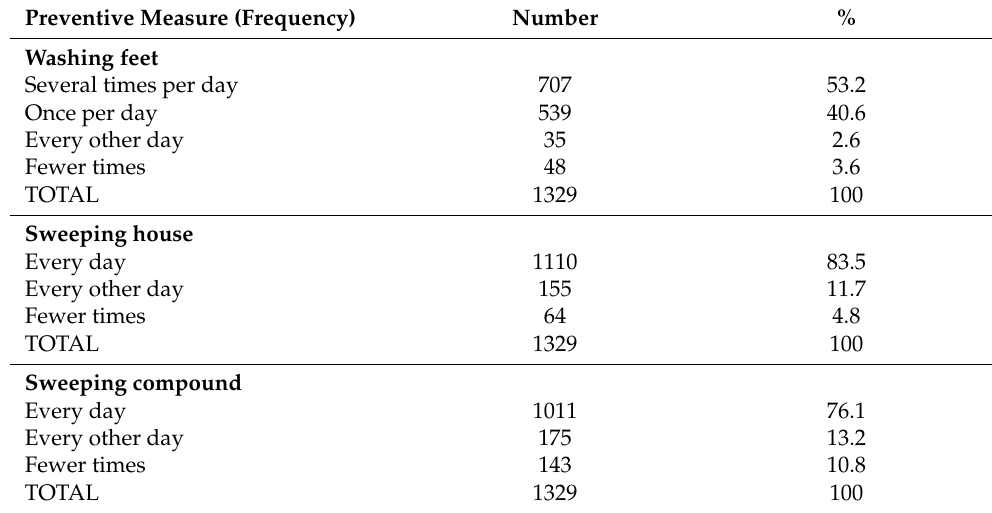
Table 7. Reported frequencies of cleaning the feet, house, and